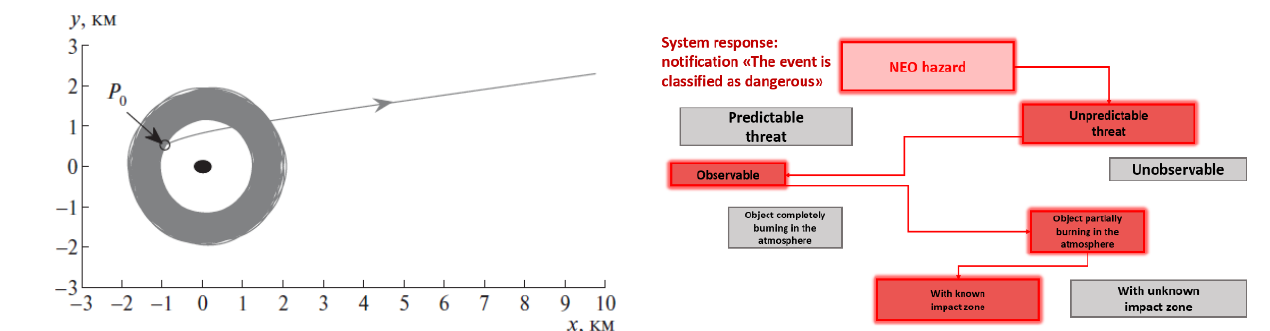
Figure 4. The orbital motion of the mini-satellite in the plane orthog- onal to the asteroid—Sun direction (Ivashkin and Guo 2019).